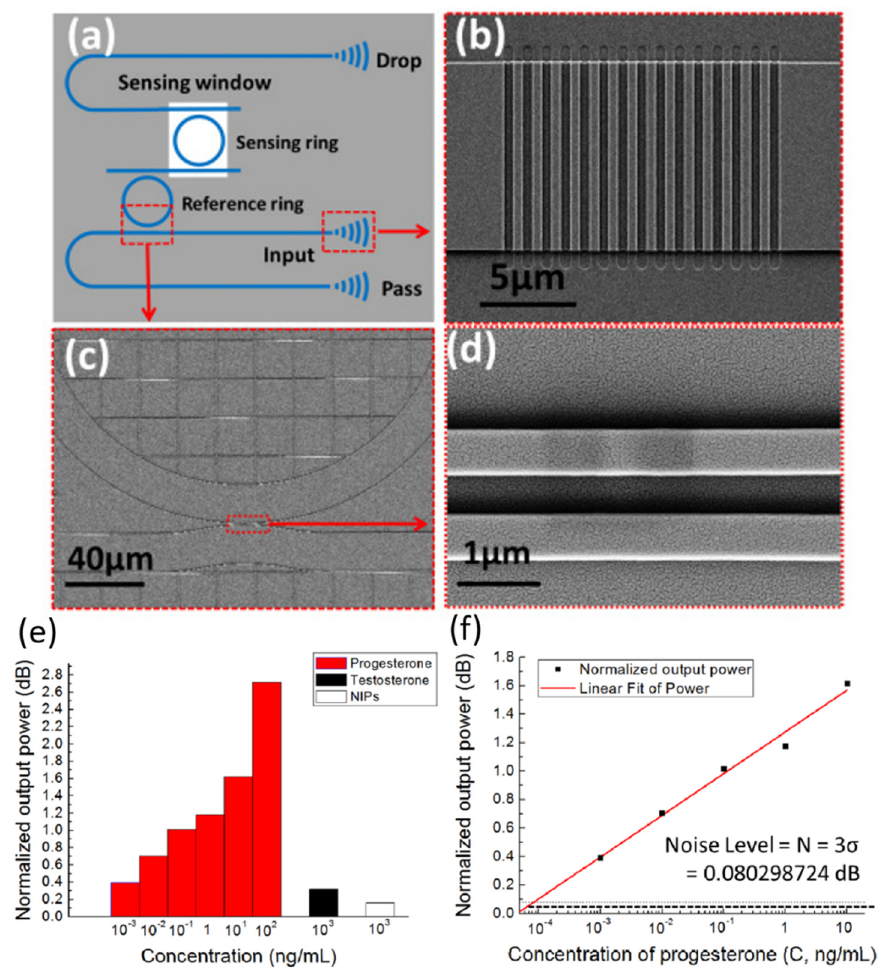
Figure 18. ( a ) Schematic of the CMRR setup. ( b , d ) SEM images of the grating used as couplers in different areas of the sensor, and ( c ) SEM of the reference ring coupled to the input waveguide. ( e ) Output power changes as a result of varying concentrations of progesterone (red), testosterone (black), and the NIP control (white), to demonstrate specificity. ( f ) Linear fit of power versus progesterone concentration. Reproduced from ref. [112] with permission © The Optical Society of America.